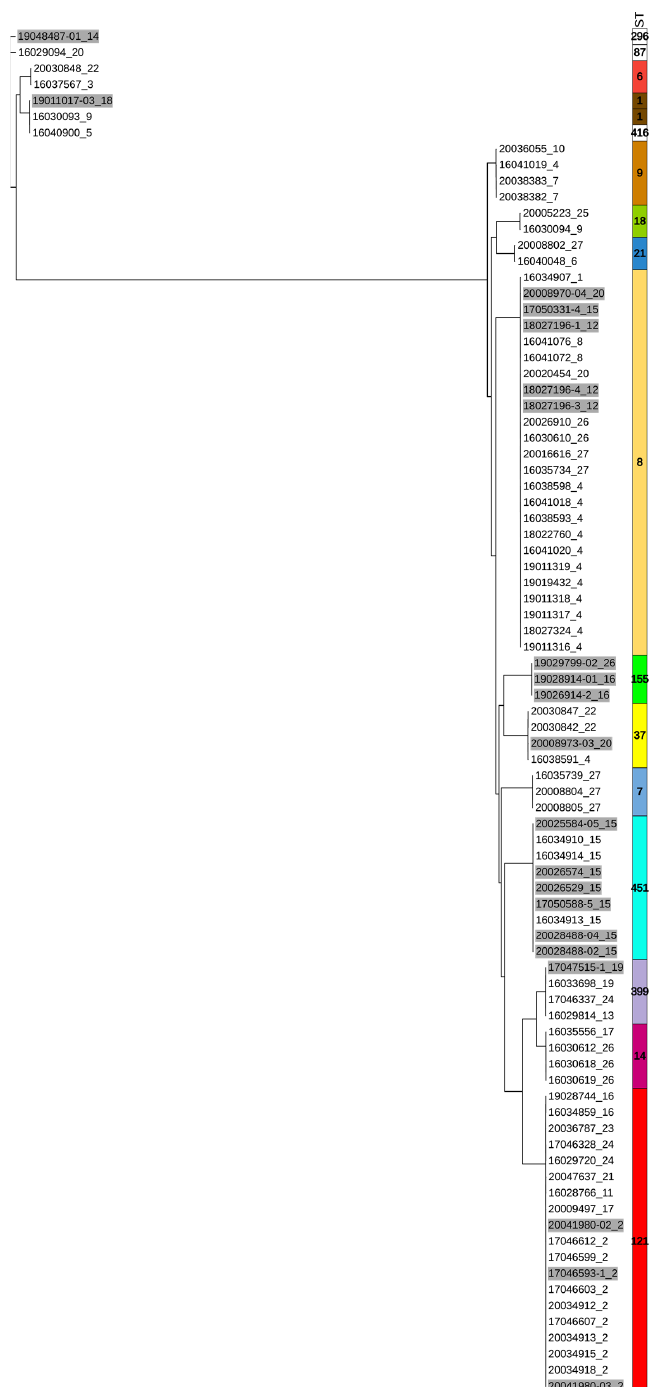
Figure 2. Phylogenetic tree of 85 Listeria monocytogenes isolates taken from food production environ- ment and products of 27 companies between 2016 and 2020, based on SNP analyses. The first two digits indicate the sampling year (16–20) and the last two digits indicate the company ID; no highlight and grey highlight indicate environmental and product samples, respectively; STs are showed in the right column with colour.